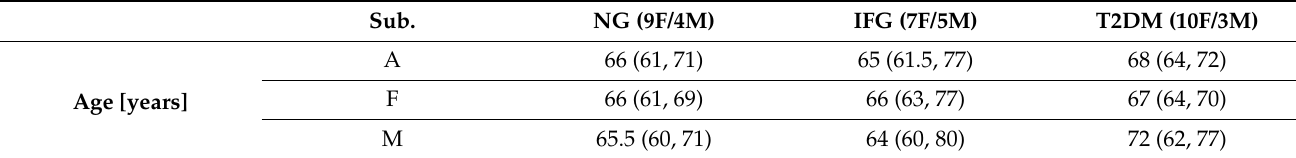
Table 1. Characteristics of study subjects. Data is presented as median with interquartile range, significance level for intergroup differences was calculated with Kruskal-Wallis one-way analysis of variance (ANOVA).